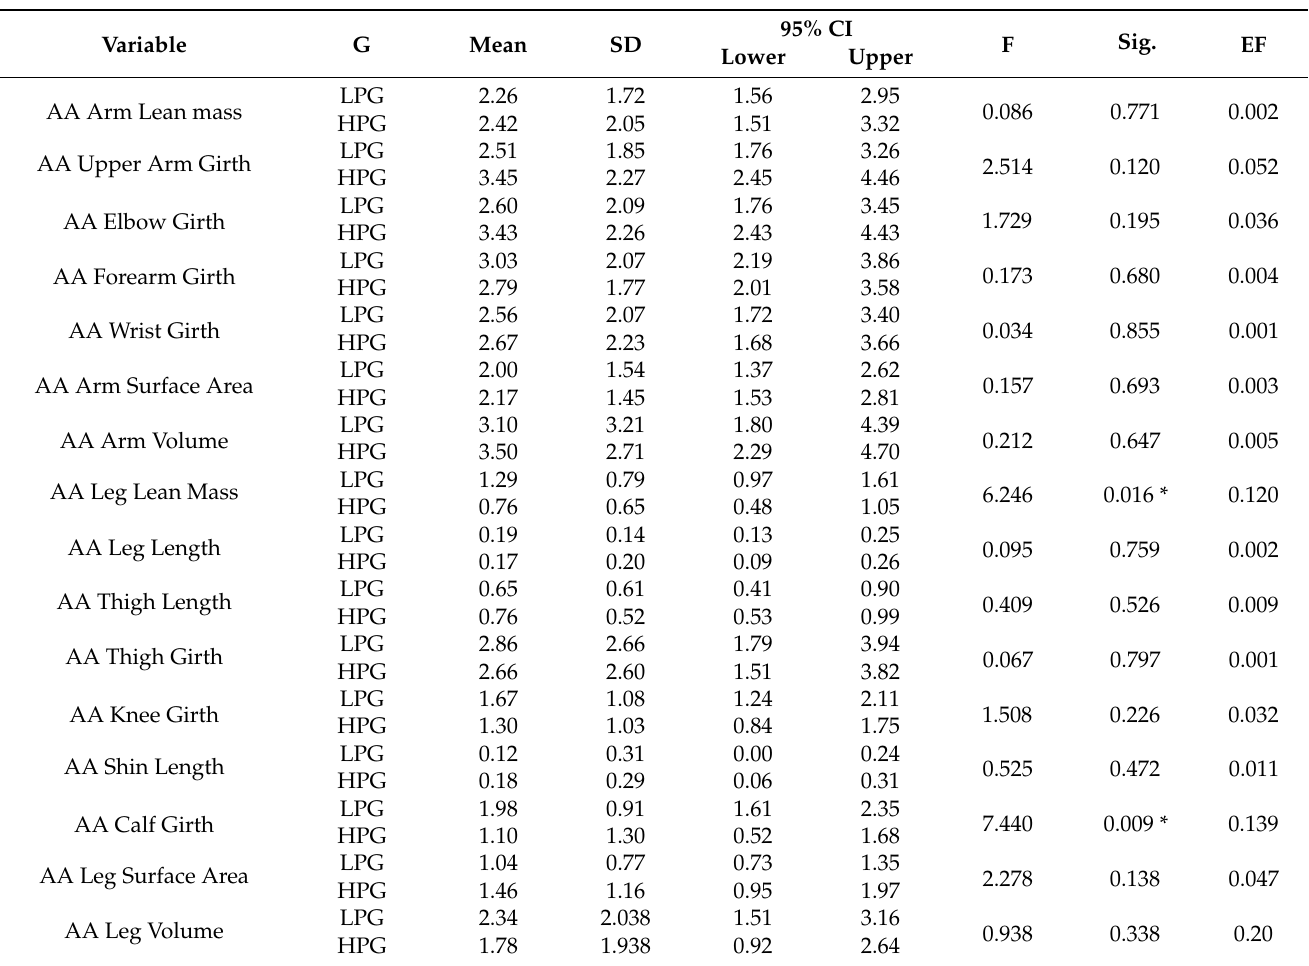
Table 5. One-way ANOVA with the descriptive presentation of the Absolute Asymmetry Index (AA) of paired morphological measurements of LPG and HPG with means ( ± SD), 95% confidence interval (CI) values and effect sizes.